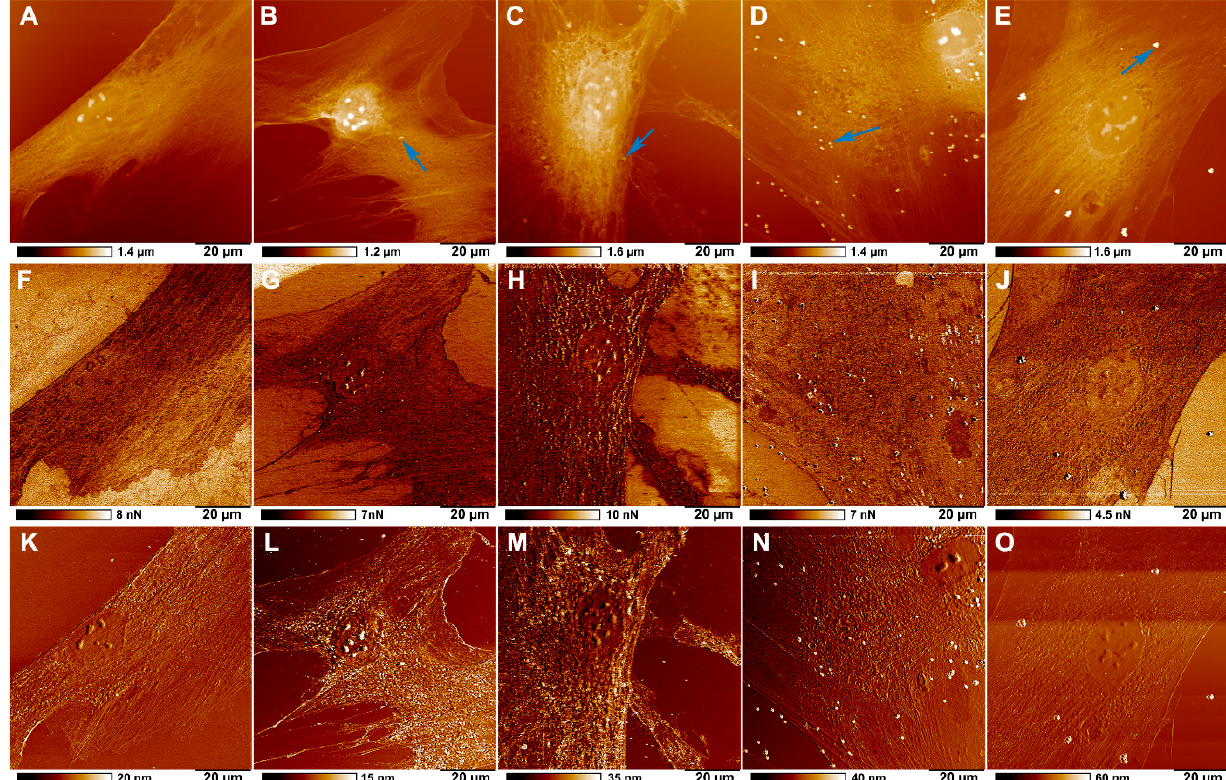
Figure 5. AFM images of topography ( A – E ), adhesion ( F – J ), and deformation ( K – O ) showing the distribution of polystyrene particles in HSF after 24 h co-incubation: control ( A , F , K ); 100 nm ( B , G , L ); 200 nm ( C , H , M ); 500 nm ( D , I , N ); and 1000 nm ( E , J , O ).